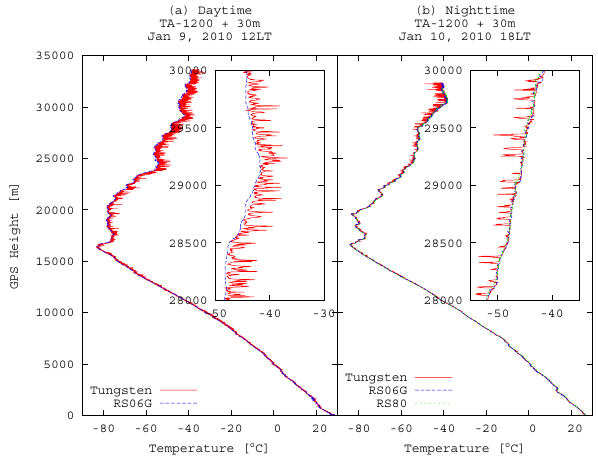
Fig. 3. Examples of the daytime (left) and nighttime (right) temper- ature ( ◦ C) profiles at Biak, Indonesia (1.17 ◦ S, 136.06 ◦ E) observed simultaneously by tungsten sonde (red), Meisei RS06G (blue) and Vaisala RS80 (green) radiosondes on 9 (left) and 10 (right) Jan- uary 2010. For visual clarity, those from RS06G and RS80 sondes are drawn in dashed and dotted lines, respectively. Inset shows the details of the pulses in fine scale. 1200-gr balloon and 30-m sus- pension line are used for both